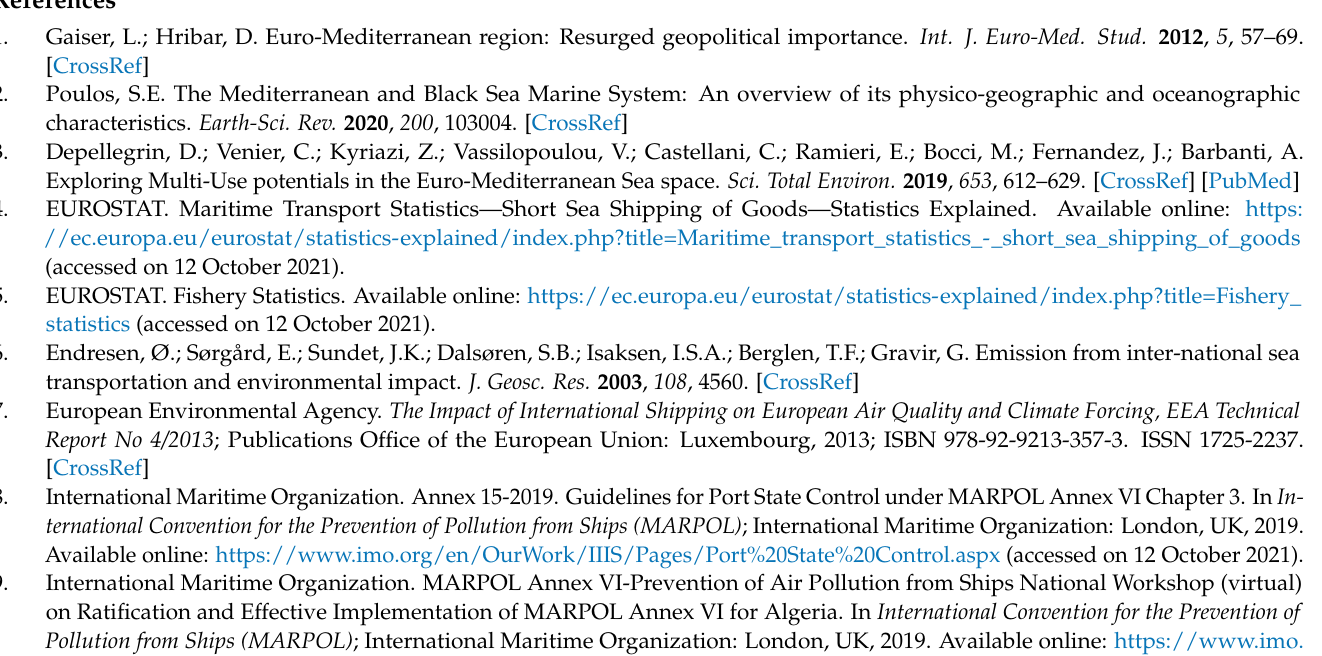
Table S1: Seasonal statistics for the shipping activities sensed by TROPOMI and simulated by LOTOS-EUROS for the Greek